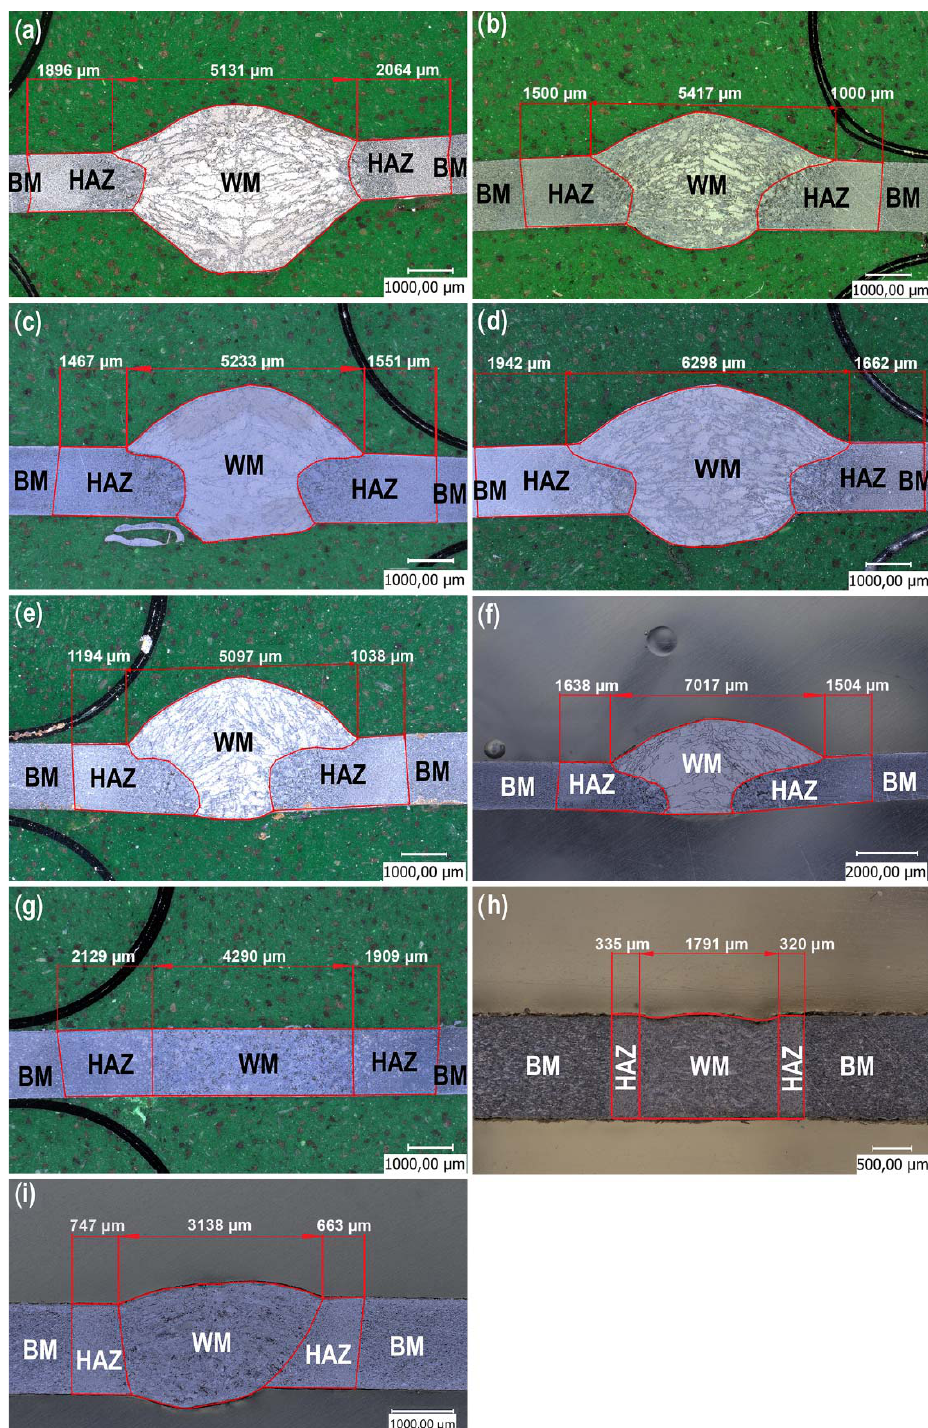
Figure 5. Representative macrostructures of cross-sections of joints depending on the bonding process used: ( a ) manual MAG135, ( b ) manual MAG138, ( c ) robotic MAG135, ( d ) robotic MAG138, ( e ) CMT solid wire, ( f ) CMT flux cored wire, ( g ) butt welding, ( h ) robotic laser, ( i ) manual laser with solid wire. Figure 6 shows the representative microstructure of the welds depending on the bonding processes. Depending on the process used, acicular ferrite (AF), polygonal ferrite (PF), boundary ferrite (GBF) and Widmanstatten ferrite (WF) [26,28] can be observed in the microstructures.